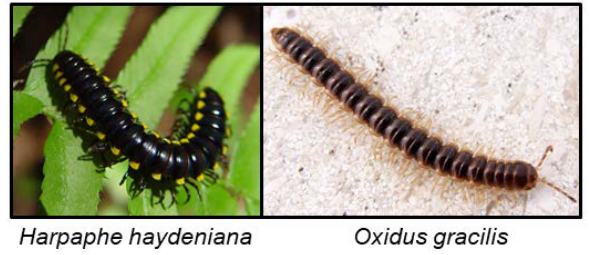
Figure 9. H. haydeniana photo by Franco Folini (https://commons.wikimedia.org/wiki/File:Harpaphe_ haydeniana_002.jpg) and O. gracilis photo by Jo ã o Coelho (https://commons.wikimedia.org/wiki/File: